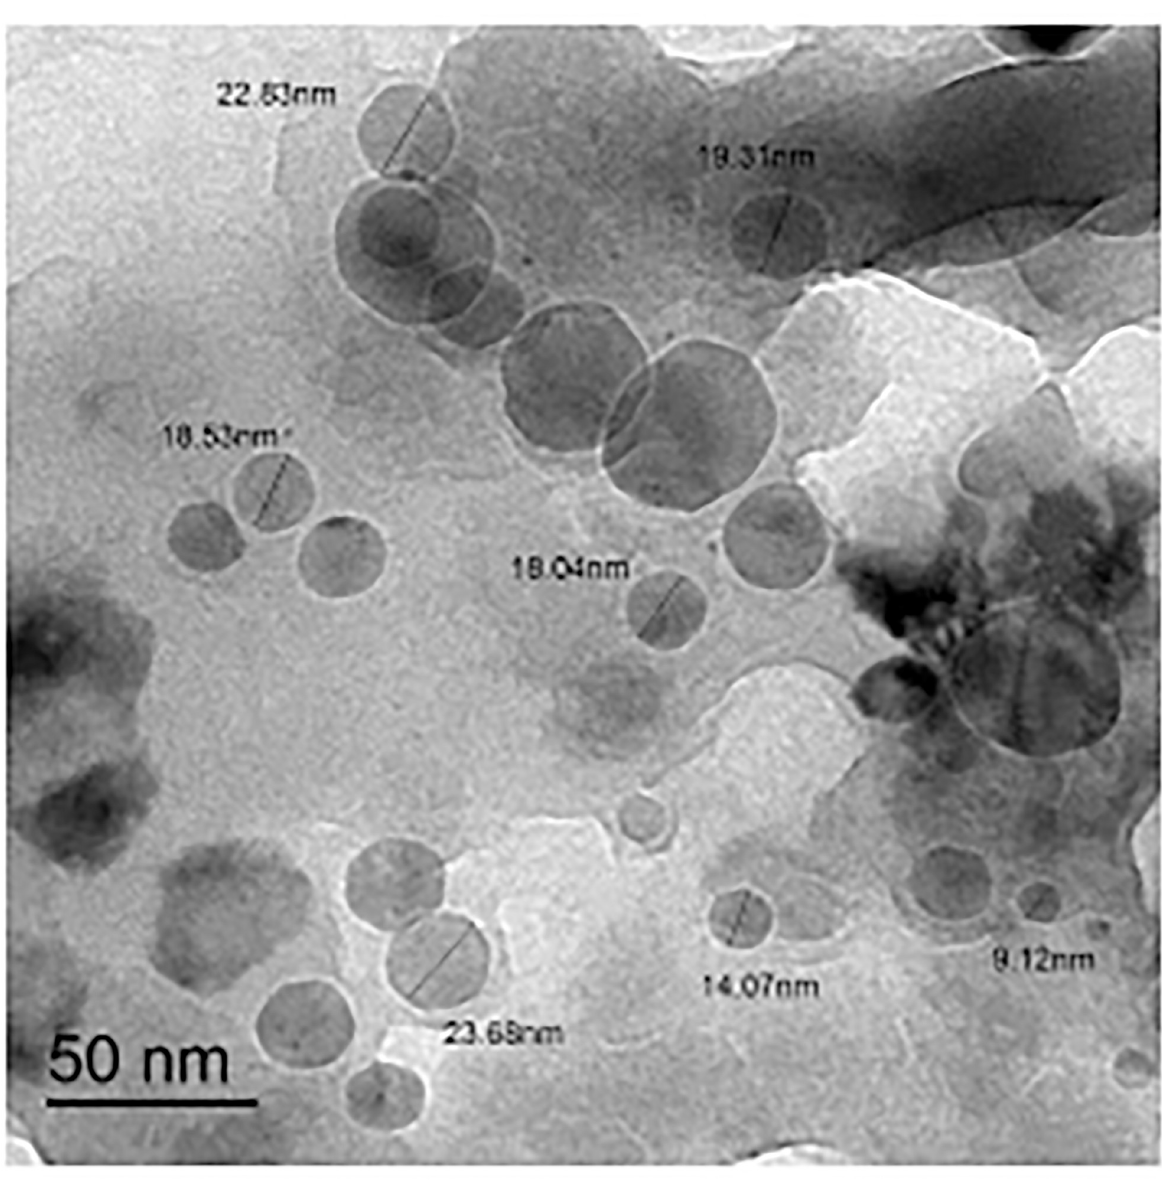
Fig 7. TEM image of zinc(II) complex. (0.04% ± 0.01%). The black area represents isotype control IgG expression and blue area repre- sent the marker expression. The results are representative of four independent experiments. Data results correspond to ± standard deviation. Lipid profile. Table 3 shows the lipid profile parameters of rats treated with MSCs, Q and Q/Zn, or both. TG levels increased by 3.09-fold in diabetic rats compared to the normal con- trol group. TG levels decreased by 39.6% and 43.2% in diabetic animals treated with Q and Q/Zn, respectively, as compared to that in diabetic animals. However, in diabetic rats treated with both MSCs and Q/Zn, TG level decreased by 61.91%, compared with the diabetic non- treated group.